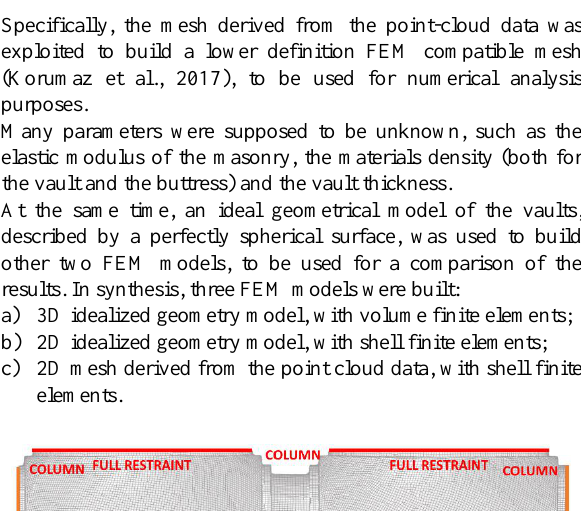
Figure 7. Intermediate phase of the vaulted elements mesh elaboration for FEM analysis